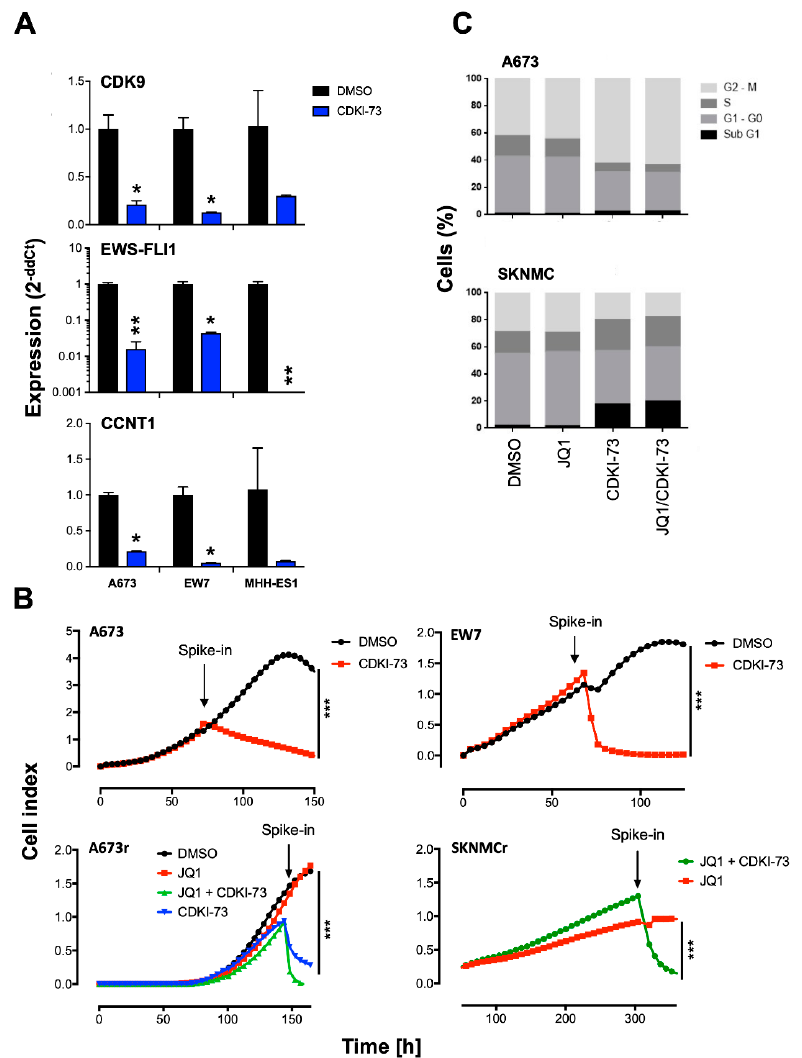
Figure 2. Effects of a new CDK9 inhibitor CDKI-73 on expression, proliferation, and cell cycle. ( A ) Analysis of expression of CDK9, CCNT1, and EWS-FLI1 24 h after treatment with 2 µM CDKI-73 in A673, EW7, and MHH-ES1 cell lines measured by qRT-PCR. Data are mean ± SEM; t -test. ( B ) Proliferation of EwS WT cell lines A673 and EW7 or JQ1-resistant A673 (A673r) and SKNMC (SKNMCr) cells was analyzed by xCELLigence assay. Upon reaching exponential growth rate, cells were treated with 2 µ M index). Data are mean ± SEM (hexaplicates / group); *** p -value < 0.0005; 2-way ANOVA. ( C ) Cell